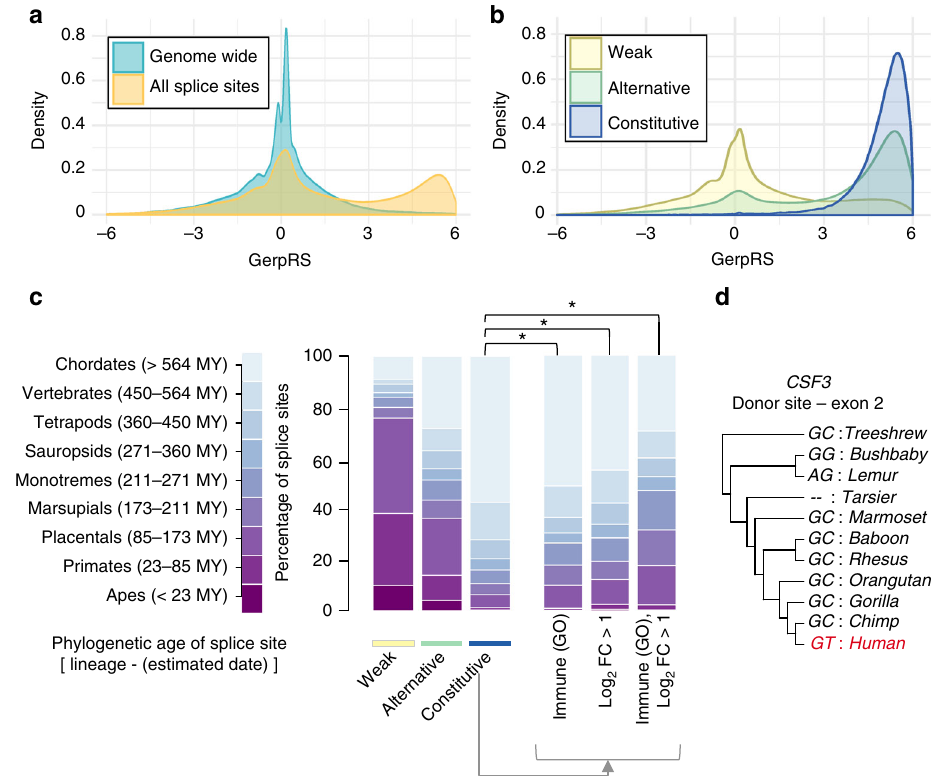
Fig. 1 Splice sites of immune genes show decreased inter-species conservation. a Conservation of splice sites shows a strong bimodal distribution (orange). One-third of splice sites show strong conservation (GerpRS > 2), whereas the remaining splice sites match genome-wide expectations (turquoise). b Breakdown of GerpRS scores according to splice site activity (weak, alternative or constitutive). c Phylogenetic age of donor/acceptor sites according to splice site activity (weak, alternative or constitutive), and breakdown of the age of constitutive splice sites, across various categories of genes. These include all genes, immune response genes (GO:0006955), stimulation-induced genes and the intersection of the latter two categories. Signi fi cance was obtained by resampling, matching for the phylogenetic age of the gene and its expression. *Resampling p < 0.001. d Example of a human-speci fi c splice site at the CSF3 gene. The phylogenetic tree is drawn according to the established phylogeny, and aligned sequences are shown at the two-base pairs matching the human splice site. Dashes ( – ) indicate alignment gap. Source data are provided as a Source Data fi